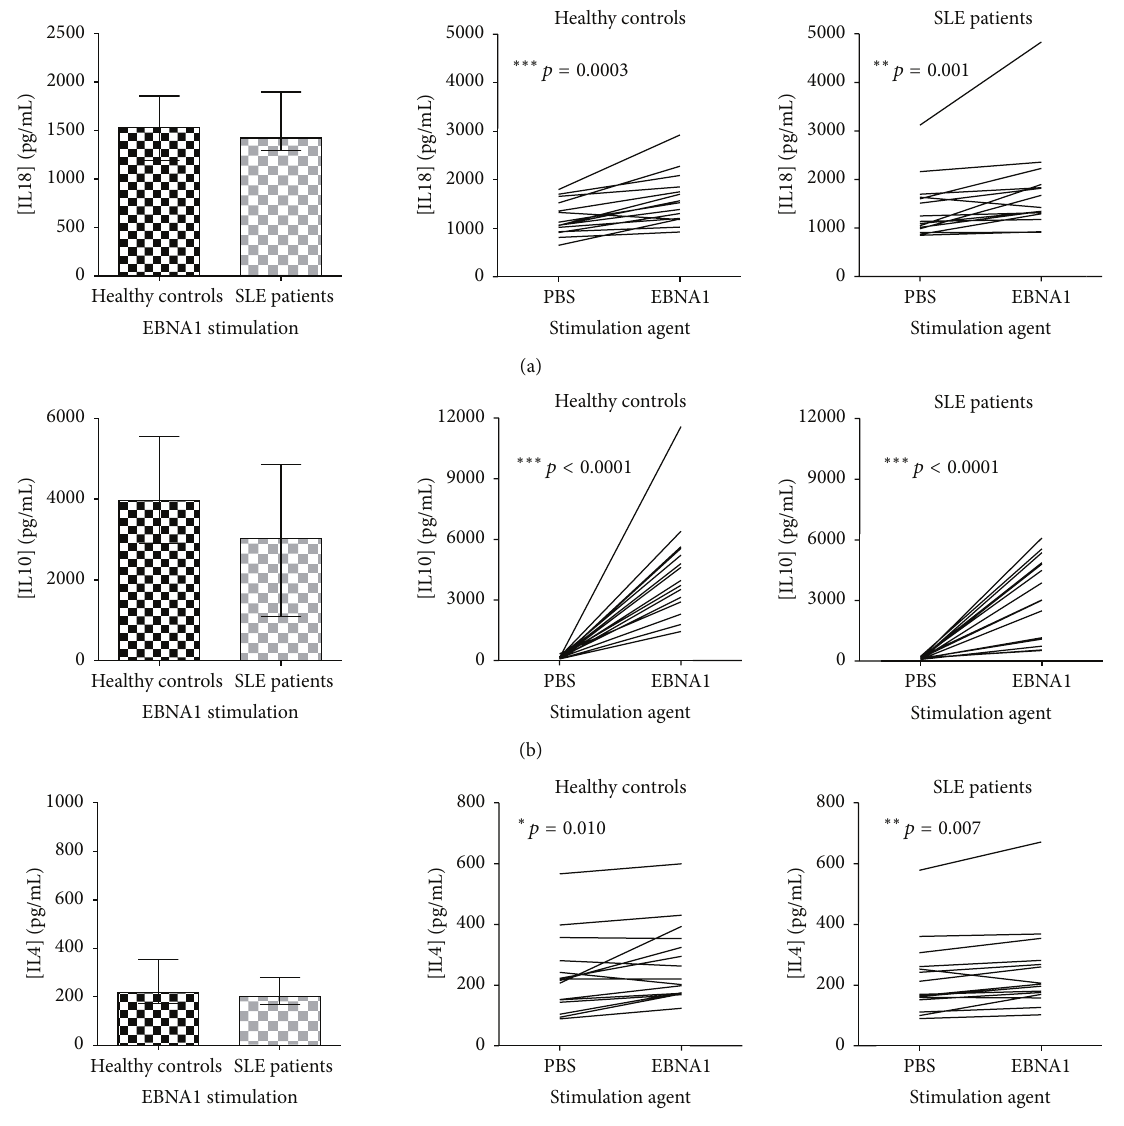
Figure 3: Cytokines involved in various T-cell responses, IL18 (a), IL10 (b), and IL4 (c), with similar induction in SLE patients and in HCs upon EBNA1 stimulation. IL18 (a), IL10 (b), and IL4 (c) quantified in dried blood spot samples from SLE patients (with normal lymphocyte levels, 𝑛 = 15 ) and sex- and age-matched HCs ( 𝑛 = 15 ) by multiplexed Luminex assay with addition of HBR+. Left: cytokine concentrations (pg/mL) in SLE patients and HCs upon EBNA1 stimulation. Data are presented as median with interquartile range. 𝑝 values for comparison of SLE patients and HCs are 0.762, 0.169, and 0.118 in (a), (b), and (c), respectively. Right: induction of cytokines (pg/mL) from basic levels (PBS stimulation) by EBNA1 stimulation in SLE patients and